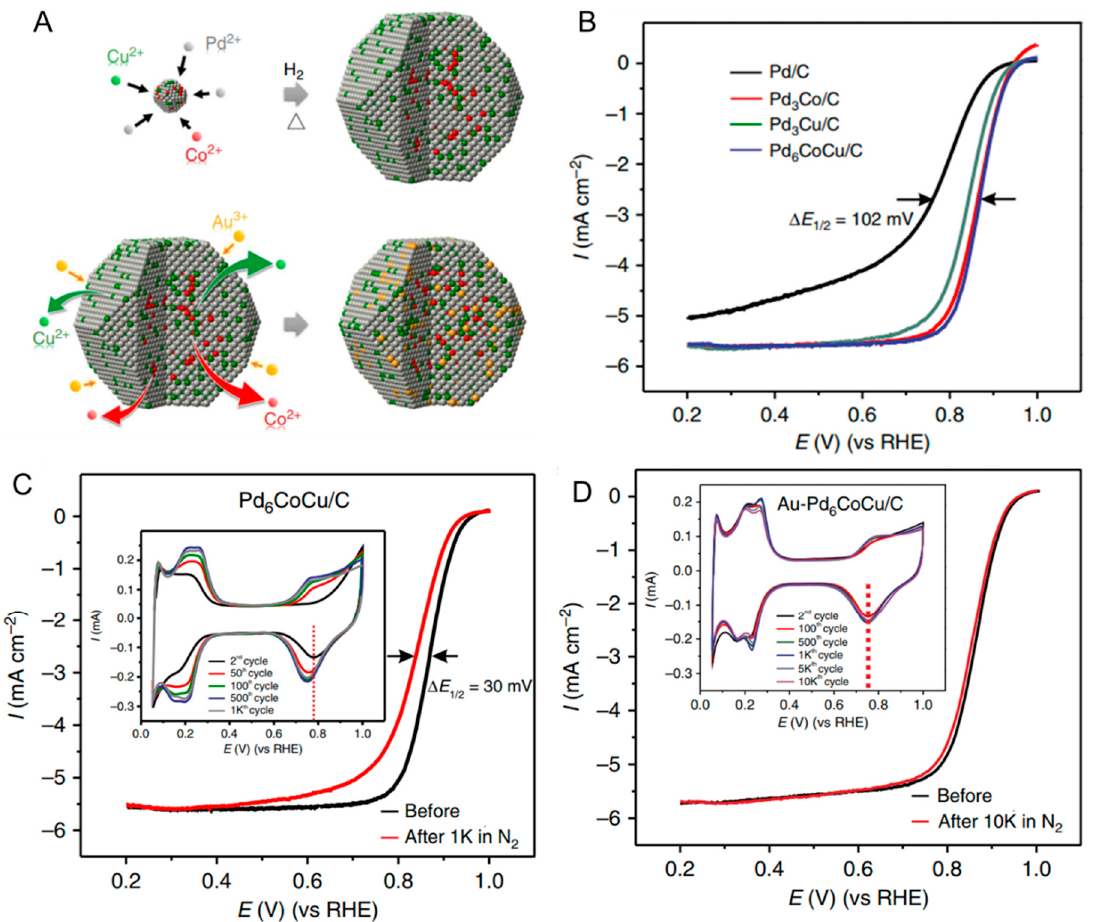
Figure 9. ( A ) Schematic of the preparation of Au-doped ternary PdCoCu. ( B ) Comparison of ORR polarization curves of various Pd-based catalysts in an O 2 -saturated 0.1 M HClO 4 solution with a sweep rate of 5 mV s − 1 . ( C ) Anodic sweep voltammograms for ORR on Pd 6 CoCu/C before and after 1000 potential cycles, and ( D ) the anodic sweep voltammograms for ORR on Au-Pd 6 CoCu/C before and after 10,000 potential cycles [92].